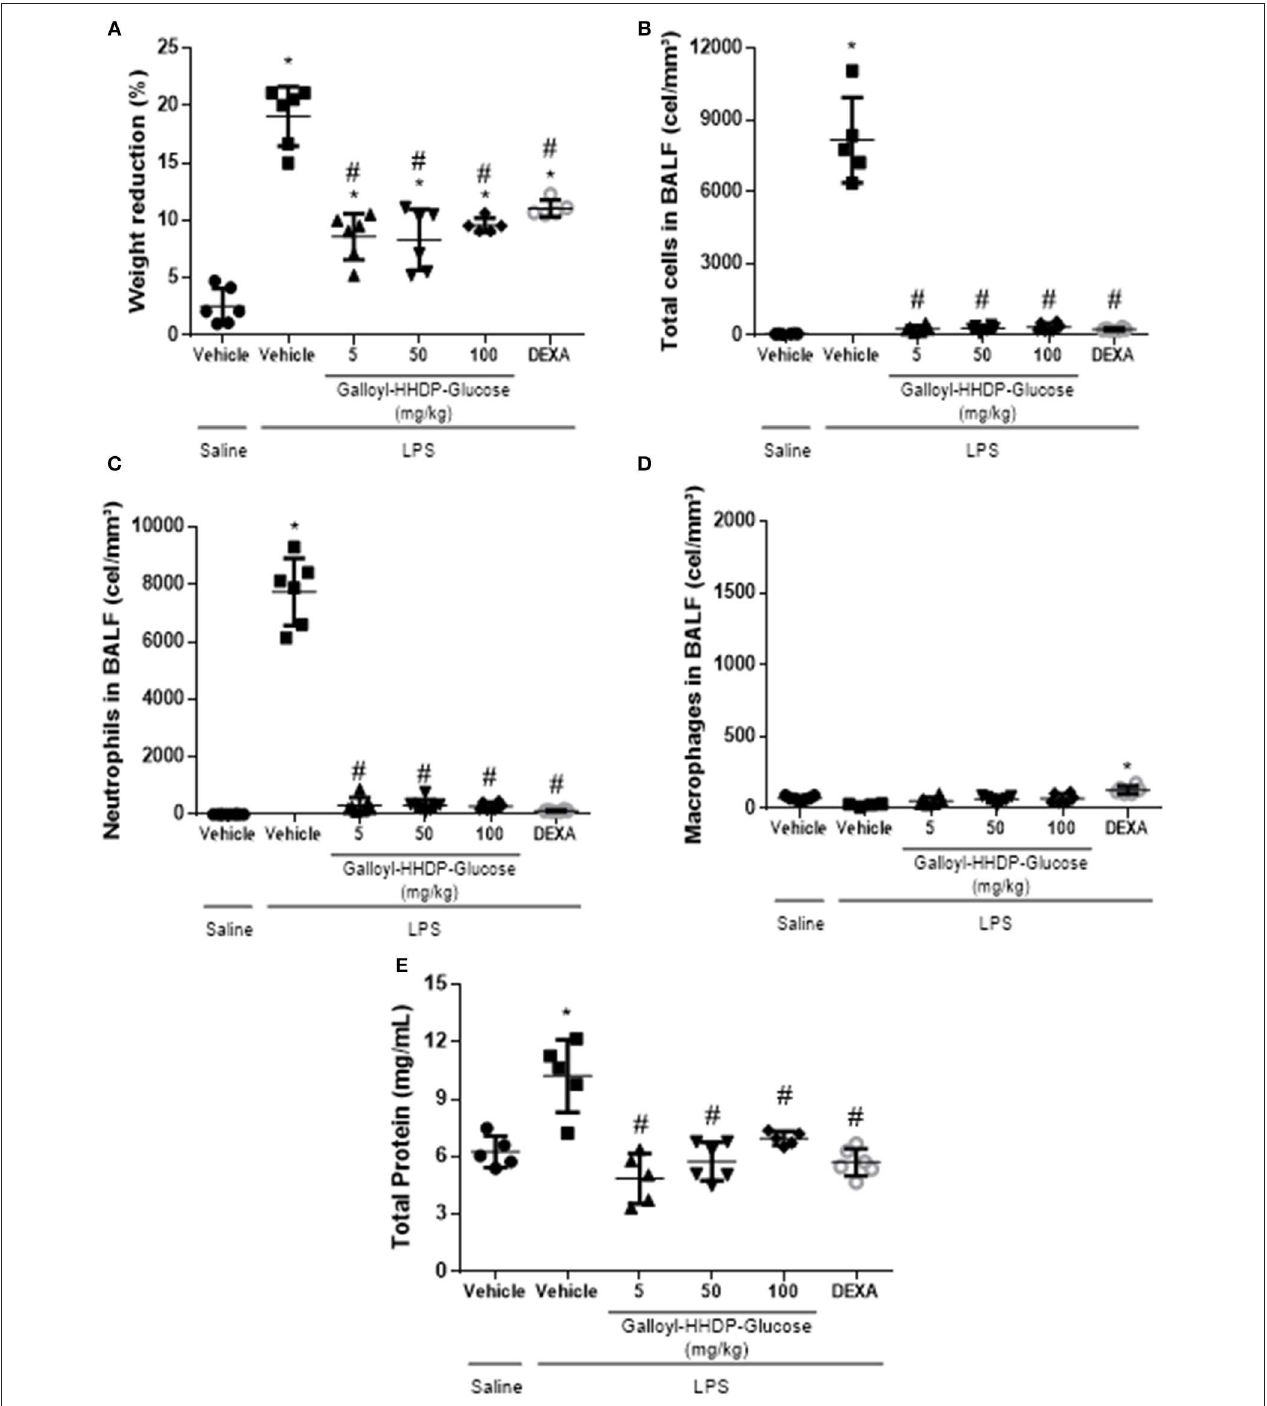
FIGURE 5 | Analyses of body weights of mice. (A) Effects of galloyl-HHDP-glucose treatment on the total number of leukocytes (B) , neutrophils (C) , or macrophages (D) in bronchoalveolar lavage fluid (BALF), and total proteins in lung (E) . BALB/c mice were randomly allocated to 6 groups ( n = 6/group). Mice received galloyl-HHDP-glucose (5, 50, and 100 mg/kg; p.o), dexamethasone (DEXA; 5 mg/kg; p.o), or vehicle (PBS; p.o). The values are presented as mean and SD. Significances were calculated by One-way ANOVA followed by Tukey test analysis of the groups vs. saline-injected non-treated mice (* p < 0.05) and vs. lipopolysaccharide (LPS)-installed non-treated mice ( # p < 0.05).